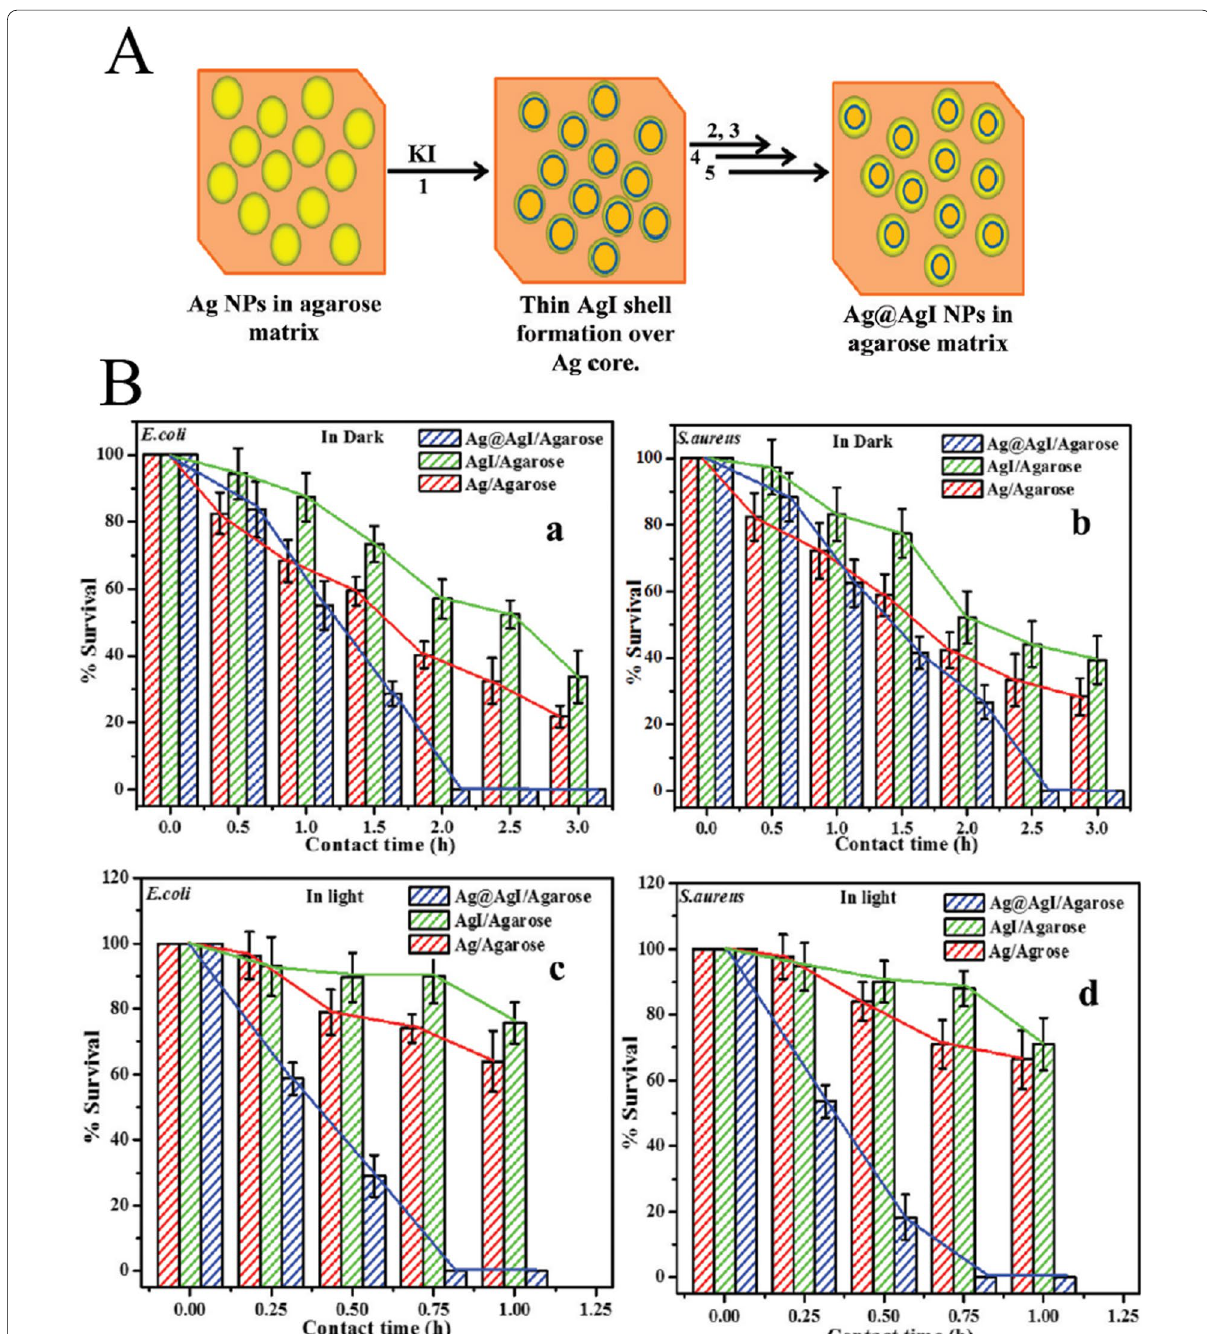
Fig. 13 A Schematic illustration of the stepwise formation of core@shell structure of Ag@AgI in agarose matrix. B Viable cell count test by nutrient agar plating: percentage survival bacteria versus contact time for (a) E. coli and (b) S. aureus in the dark, and (c) E. coli and (d) S. aureus in the presence of light. Adapted from Ref. [7] with permission. Copyright (2012)